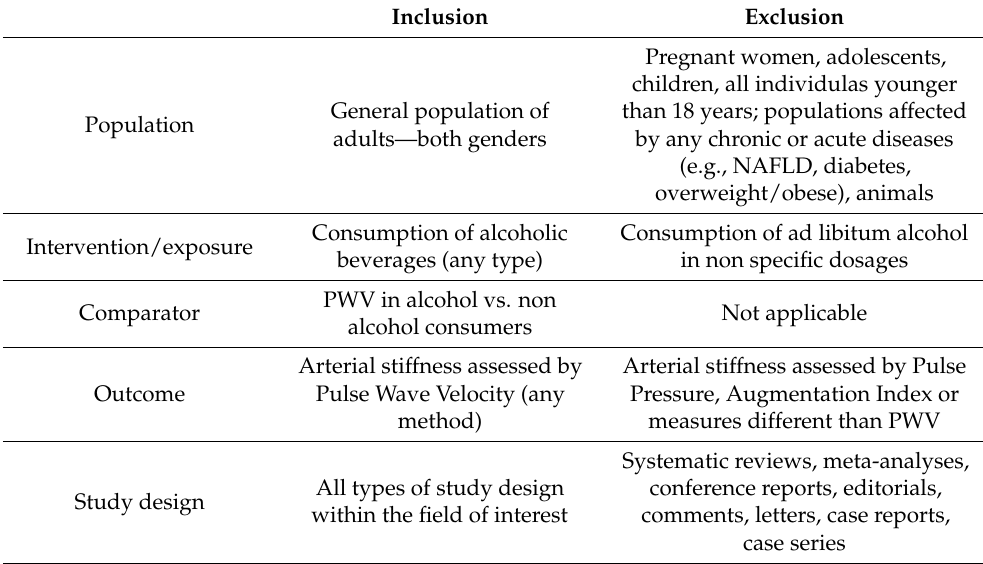
Table 1. Criteria for inclusion and exclusion of studies based on the patient, intervention, comparison and outcome (PICO)